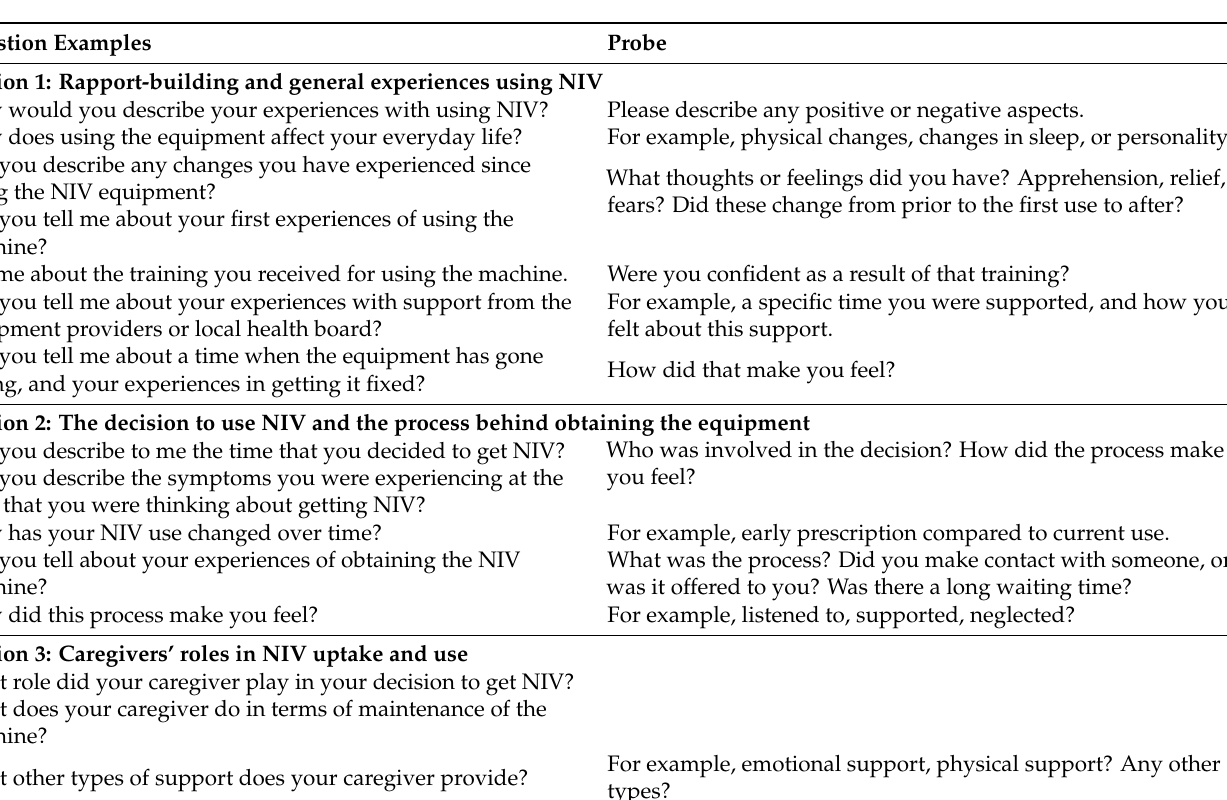
Table A1. Semi-structured interview